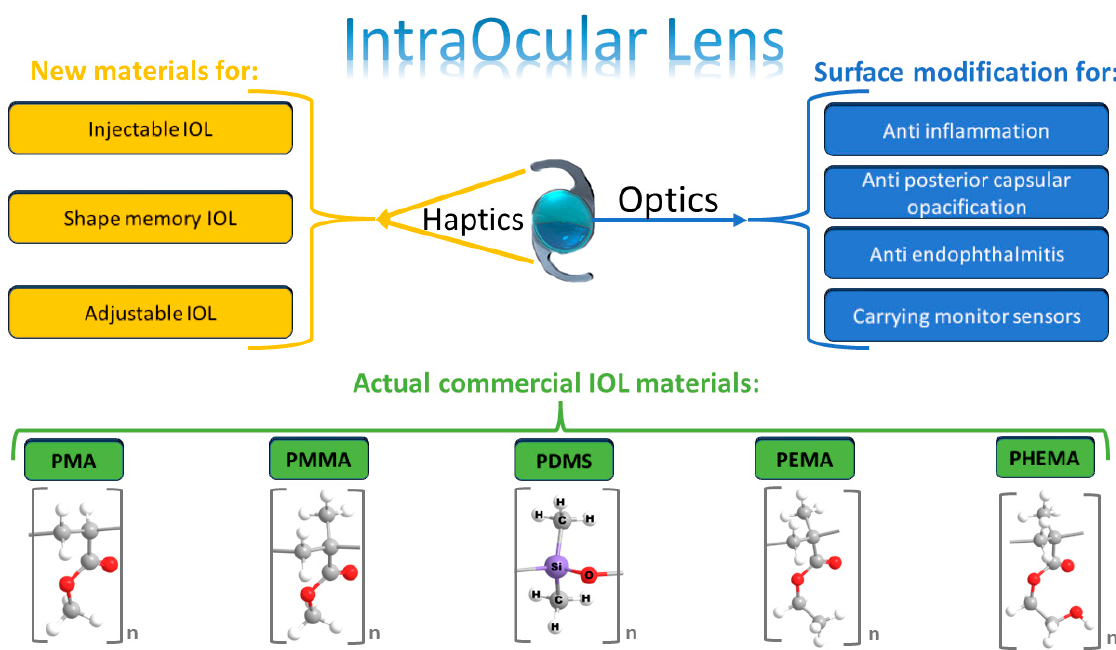
Figure 1. Scheme of commercial IOL indicating the main elements of an IOL: optics and haptics. The effects of IOL surface treatments and the main polymeric materials adopted in commercial IOL. Adapted from Ref. [2] under the terms of the Creative Commons Attribution (CC BY) license. Copyright © 2022 Luo, Wang, Chen, Xu, Yin and Yao.